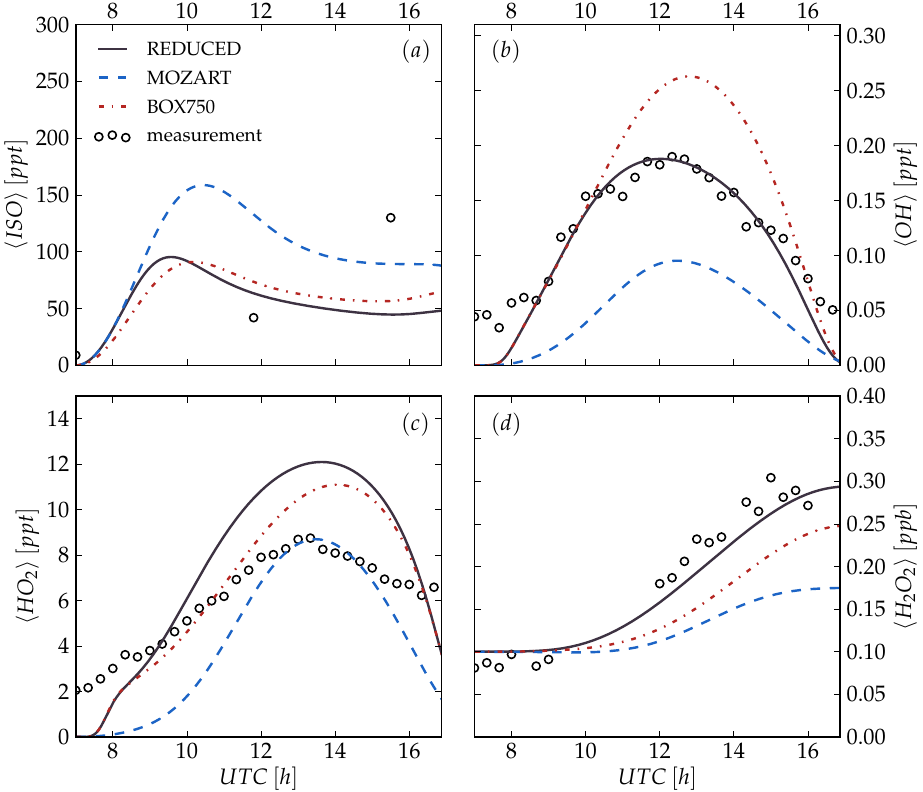
Fig. 5. Measured and modeled mixed-layer mixing ratios of Isoprene, OH, HO 2 and H 2 O 2 as measured and modeled with MXLCH (using both MOZART and the reduced chemical scheme) and the box model (using the reduced chemistry